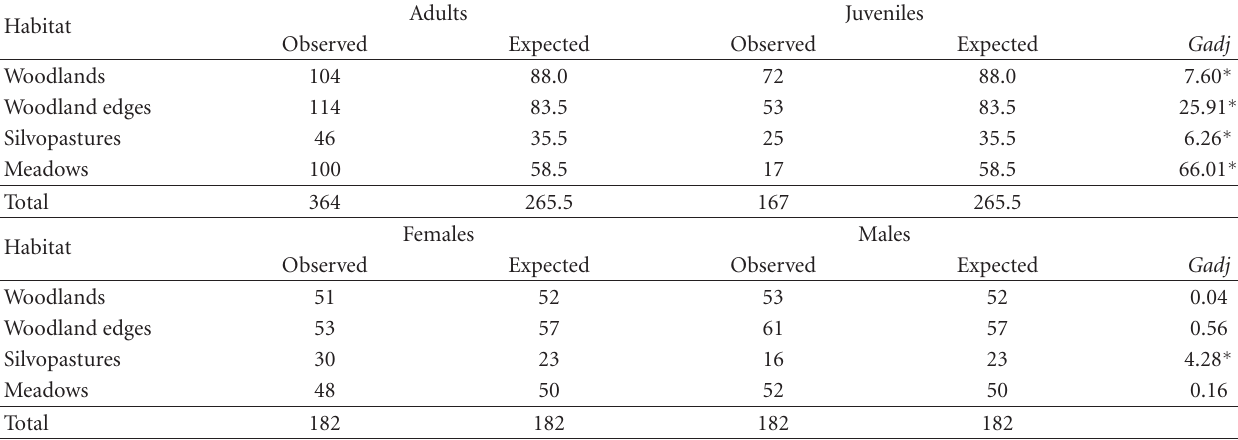
Table 2: Numbers of adult male, female, and juvenile Plethodon cinereus from four habitats in southern West Virginia, 2004-2005,